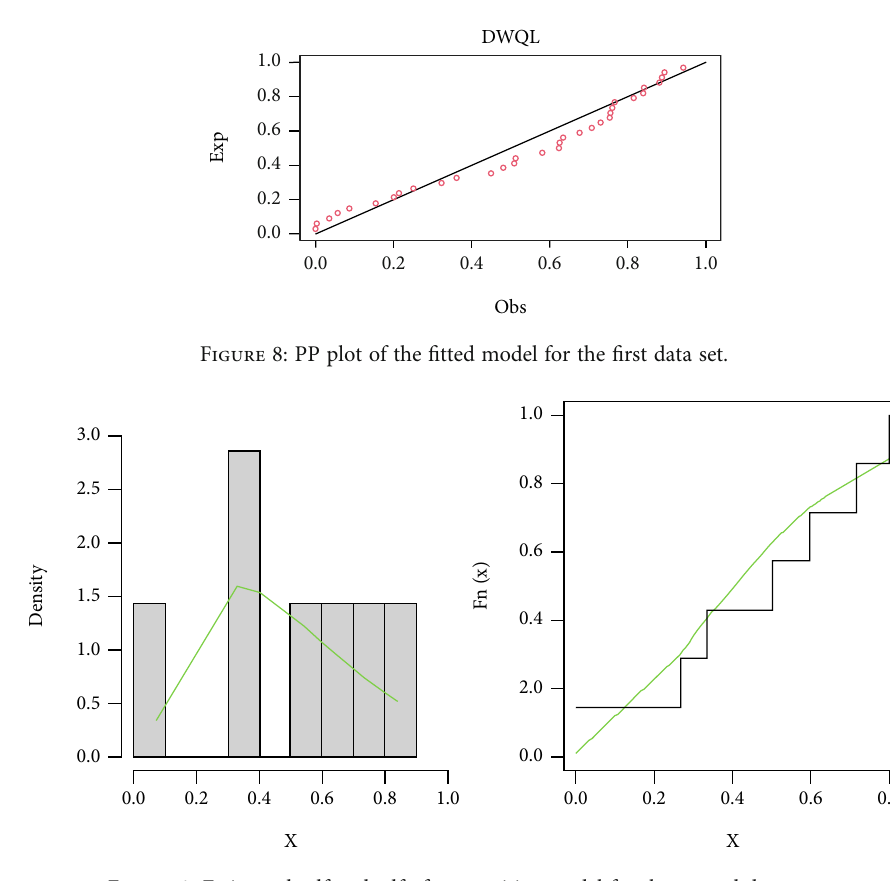
Figure 9: Estimated pdf and cdf of competitive model for the second data set.